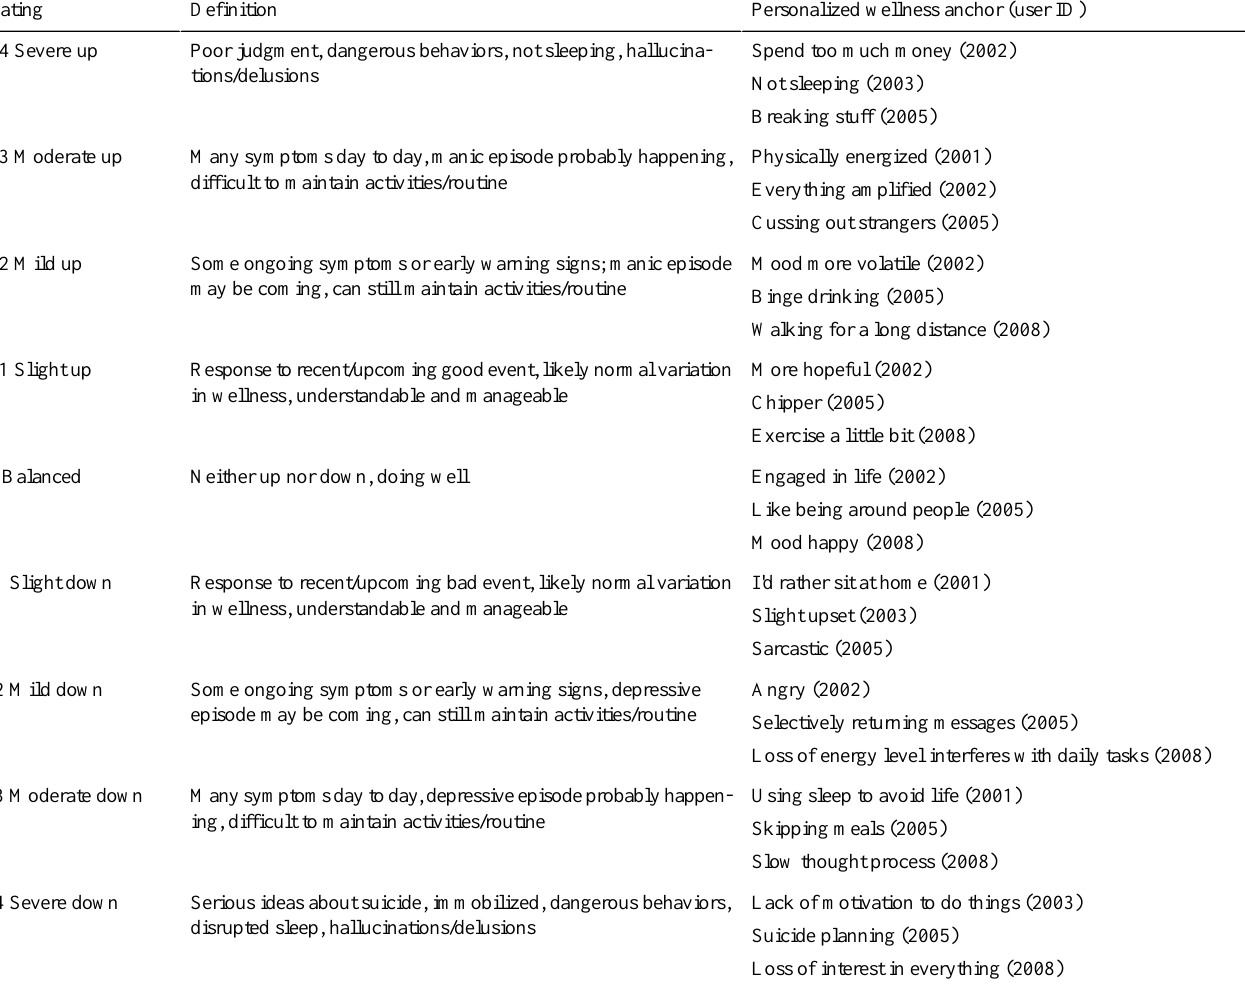
Table 2. Design sessions: wellness rating scale